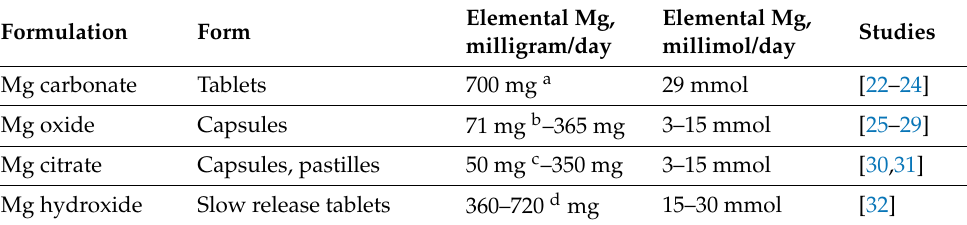
Table 1. Commonly used oral magnesium supplements in intervention studies in people with CKD.